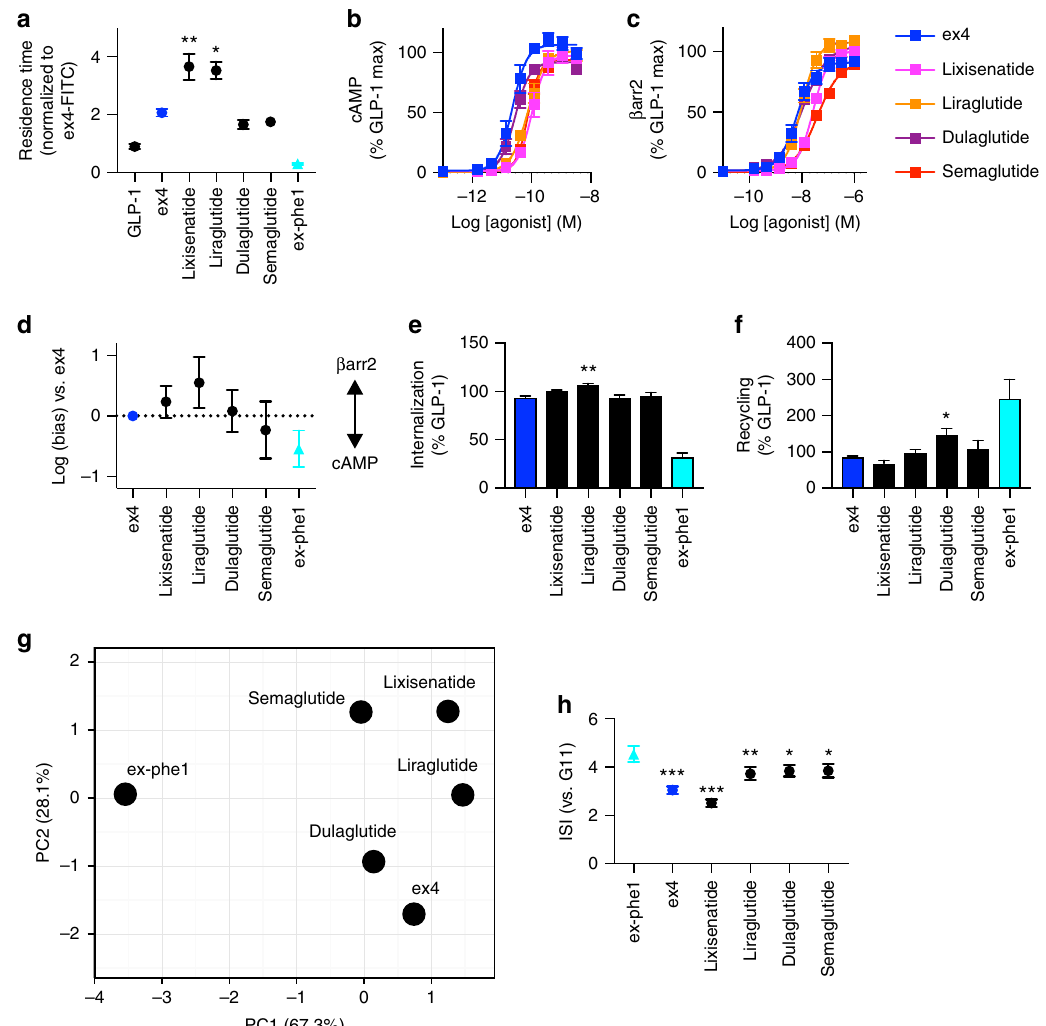
Fig. 6 Comparison with licensed GLP-1R agonists. a Agonist residence time, measured by TR-FRET in competition with exendin-4-FITC in CHO-SNAP-GLP- 1R cells, normalized to exendin-4-FITC response per assay, n = 5, one-way randomized block ANOVA with Dunnett ’ s test vs. exendin-4 (ex-phe1 not included in statistical analysis). Agonist-induced b cAMP, and c β -arrestin-2 responses in PathHunter CHO-GLP-1R cells, 90 min, n = 5. d Bias calculated from data in b , c , 95% CI shown. Agonist-induced e internalization (60 min), and f recycling (60 min, measured in presence of 10 μ M exendin(9-39) to block rebinding) in CHO-SNAP-GLP-1R cells, normalized to GLP-1 response per assay , n = 5, one-way randomized block ANOVA with Dunnett ’ s test vs. exendin-4 (ex-phe1 not included in statistical analysis). Note that exendin-phe1 results, from a different set of experiments, are shown in a and d – f , for purposes of comparison, after normalization to a reference ligand on a per assay basis. g Principal component analysis taking into account agonist k off , Δ log ( τ / K A ) for cAMP and β -arrestin-2, internalization (60 min), and recycling (60 min). h Prolonged insulin secretion in INS-1 832/3 cells, 16 h, n = 6, one-way randomized block ANOVA with Dunnett ’ s test vs. exendin-phe1. Agonists applied at 100 nM, except where indicated. * p < 0.05, ** p < 0.01, *** p < 0.001, by statistical test indicated above,. Except where indicated (bias plot), error bars indicate